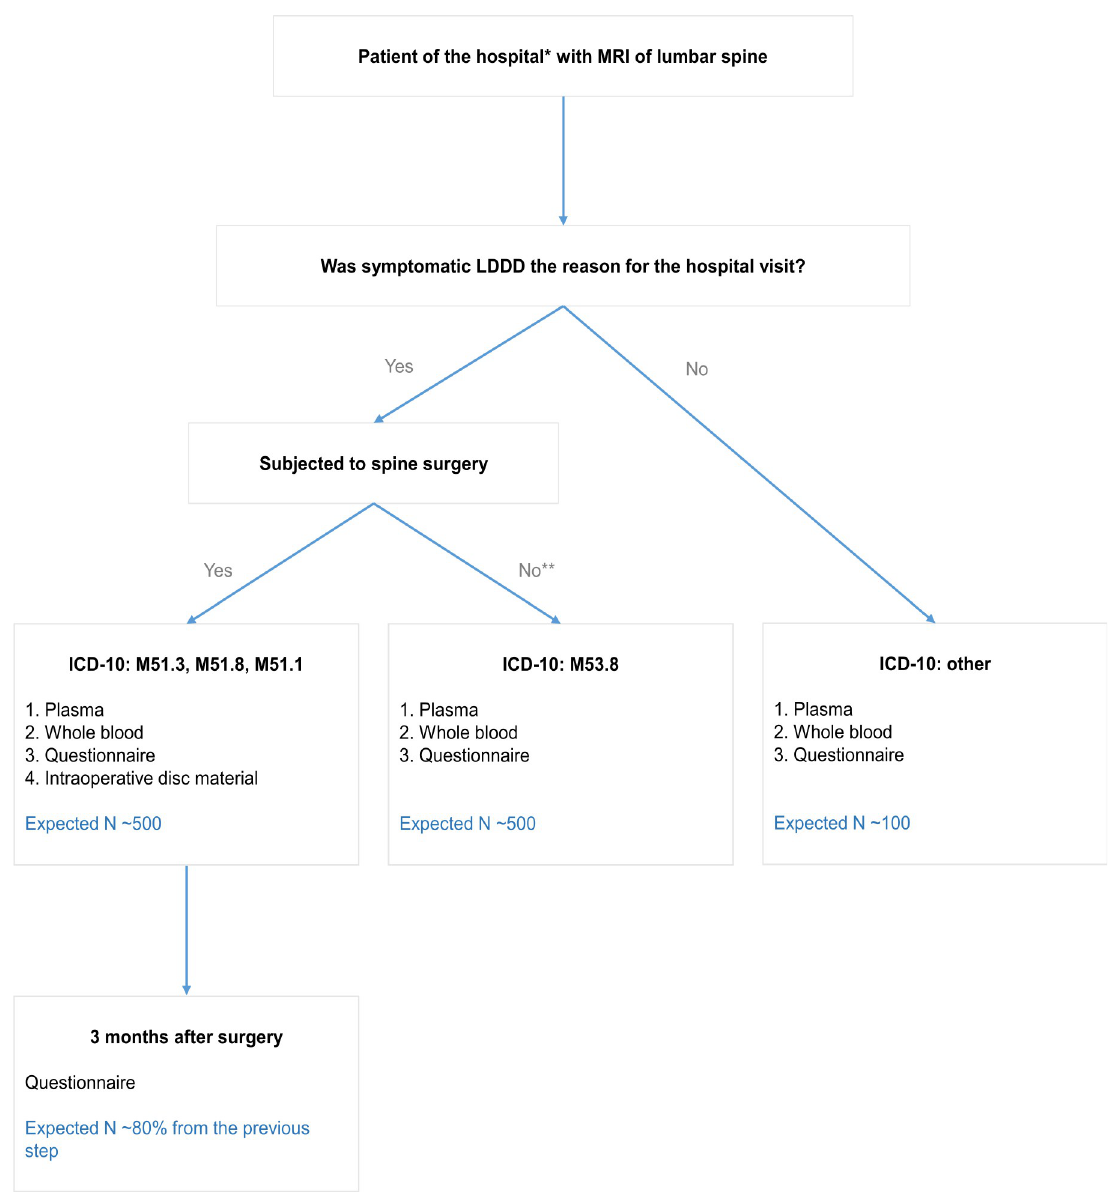
Fig 1. Patient selection. Sample size at various time-points of the project. Expected total sample size is 1,100. � Novosibirsk Research Institute of Traumatology and Orthopedics (NRITO) / Priorov National Medical Research Center of Traumatology and Orthopedics (Priorov CITO). �� Conservative